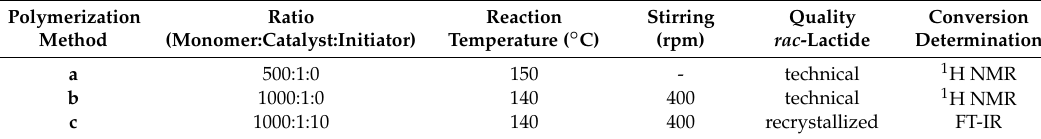
Table 4. Polymerization conditions for polymerization methods a – c .